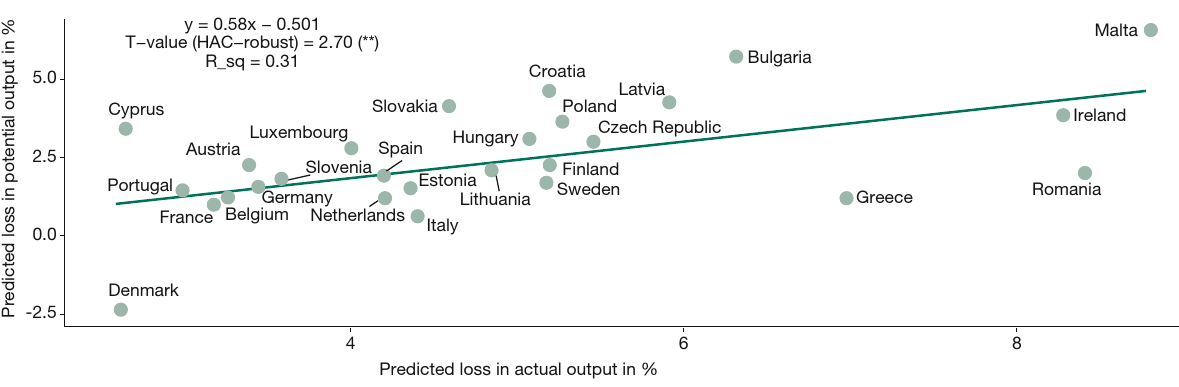
Figure 5 Revisions in potential output due to the COVID-19 shock, 2021 Correlation of actual and potential output losses: Spring 2020 forecast vs. Autumn 2019